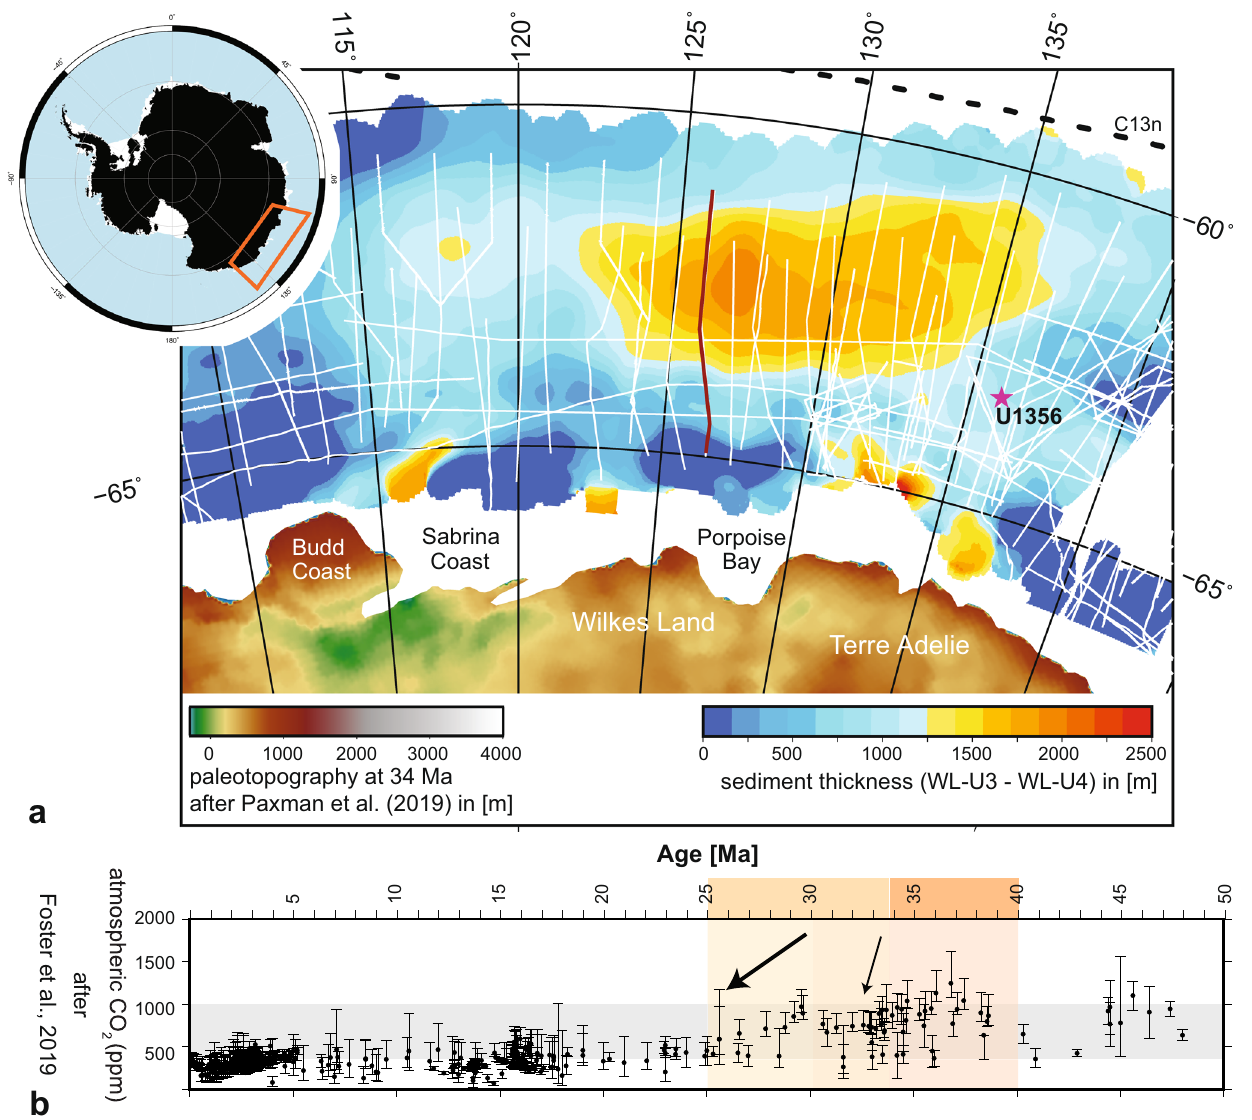
Fig. 1 | Sedimentation and atmospheric CO 2 during the early Oligocene. a SedimentthicknessoftheEarlyOligoceneStrata(EOS)offshoreWilkesLand,East Antarctica. White lines indicate available seismic re fl ection data, magenta star indicates IODP Site U1356. Paleotopography on continent is masked to modern continental outline 31 . Black dashed lines indicate magnetic anomaly C13n (33.5Ma) 57 , representing the approximate location of the spreading ridge in the